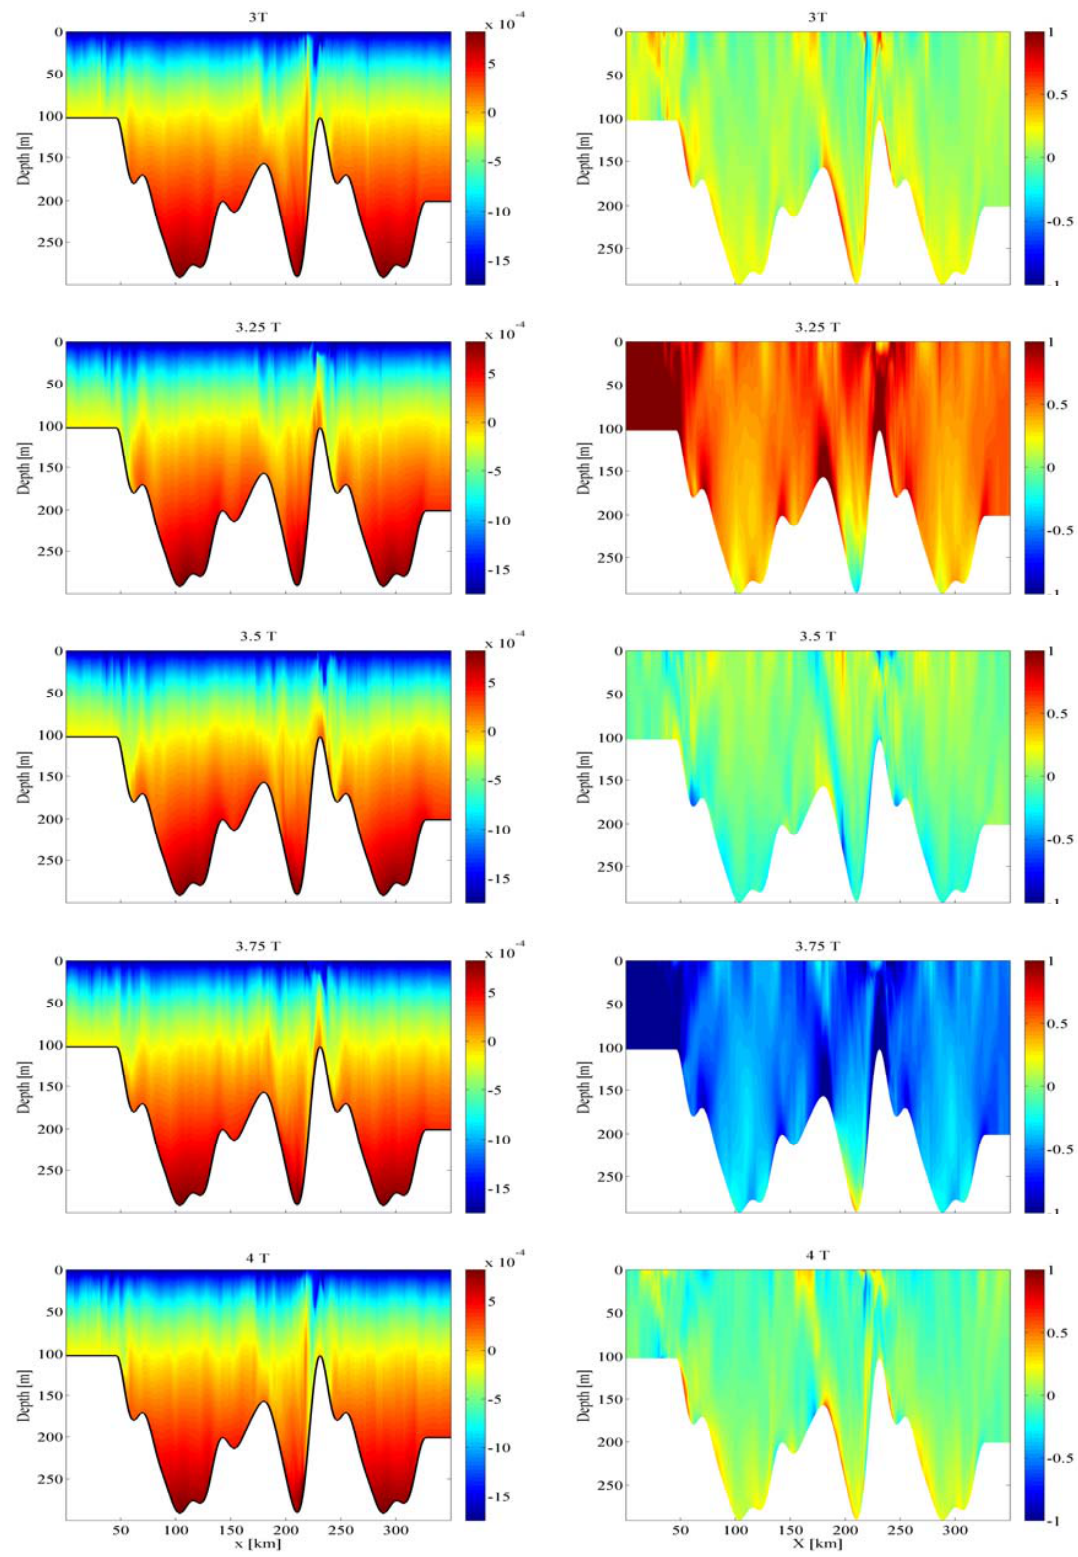
Fig. 5. Snapshots of the normalized density (left panel) and horizontal velocity (in ms − 1 ) (right panel).